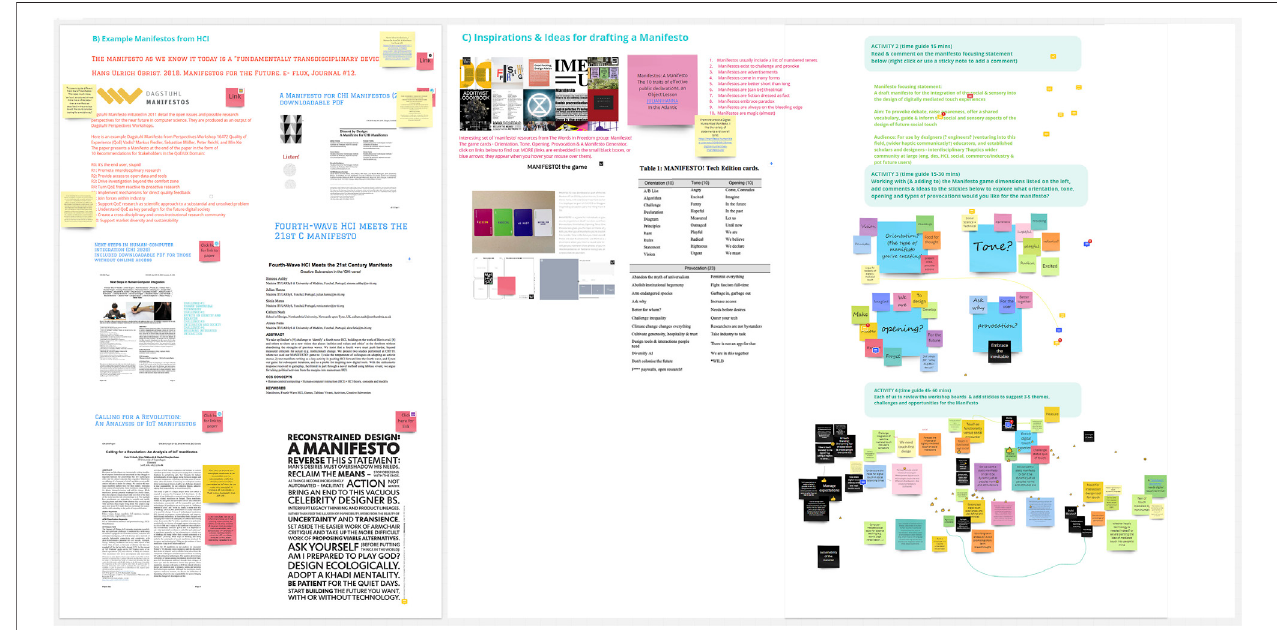
FIGURE 2 | Example manifestos from HCI and inspirations and ideas for drafting a manifesto.